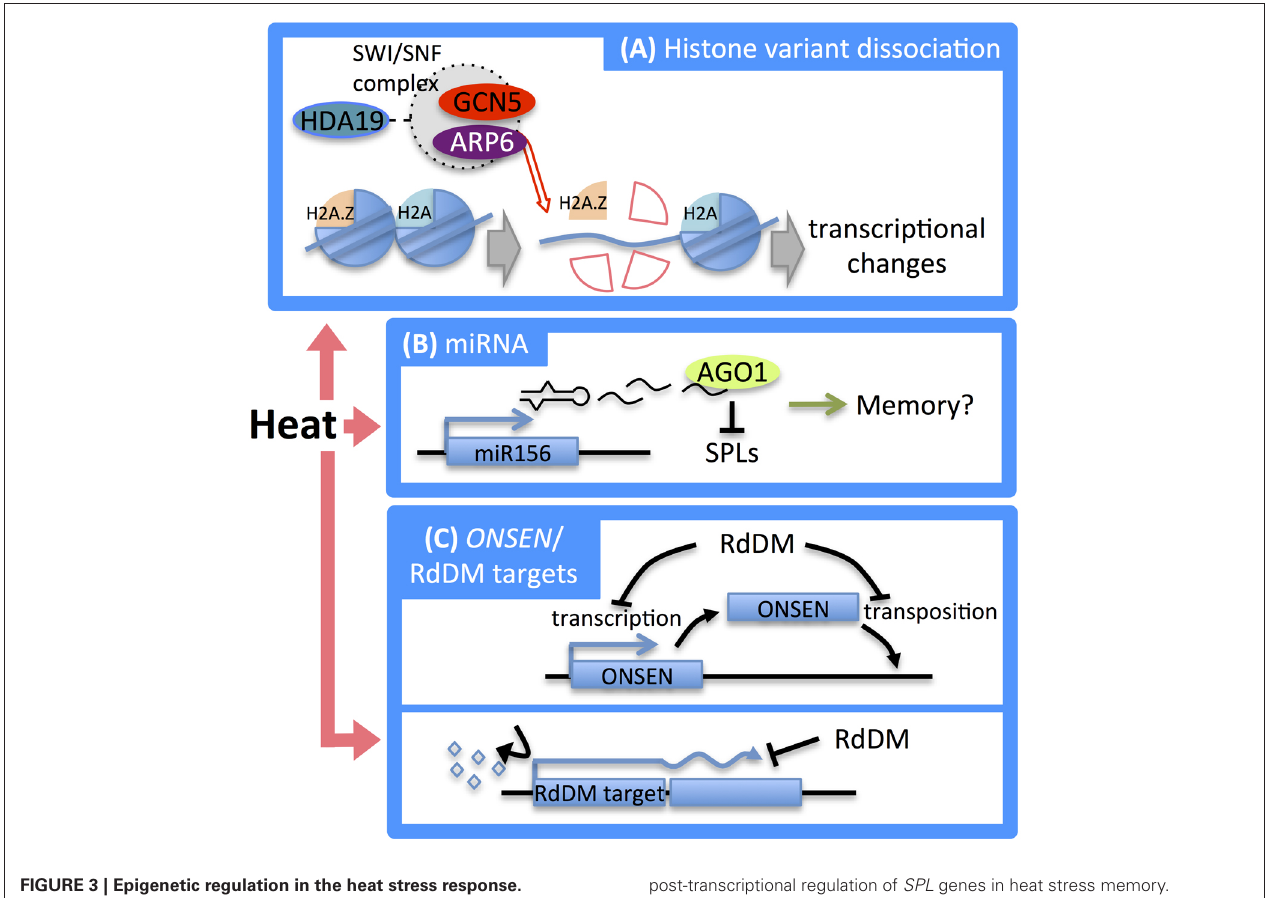
FIGURE 3 | Epigenetic regulation in the heat stress response. (A) At high temperatures, H2A.Z is dissociated by the SWI/SNF chromatin remodeling complex which contains ARP6. This dissociation causes transcriptional changes in downstream genes. (B) After heat stress treatment, the expression of the microRNA miR156, which targets SPL genes, is increased. ago1 mutants of Arabidopsis show defects in heat acclimation, implying involvement of miR156-mediated